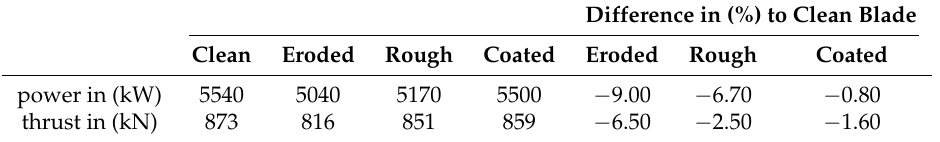
Table 4. Comparison of the aerodynamic power and rotor thrust using different sets of polars at rated conditions (reference is the clean